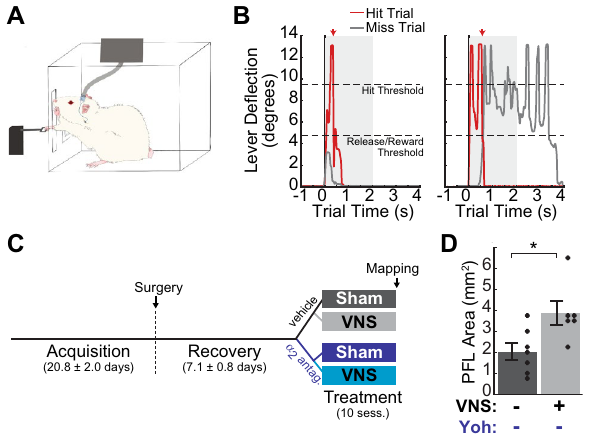
Figure 1. Experimental design. ( A ) Cartoon illustrating the skilled reaching lever-press task and VNS procedures. Rats were required to press and release a lever situated 2 cm outside the training booth within a 2 s window to receive reward ( B ) Example rewarded (Hit, red) trial and unrewarded (Miss, gray) trials from a single pretreatment session. Rats were required to press the lever past the “hit threshold” (9.5 degrees below horizontal) and return it to less than 4.75 degrees from horizontal (“Release/Reward Threshold”) in under 2 s to receive food reward. Unrewarded “Miss Trials” were those in which rats either failed to reach the hit threshold (gray trace, left) or failed to release the lever within the required time window (gray trace, right). ( C ) Experimental design and timeline. Female Sprague–Dawley rats were trained on the lever press task (Acquisition) prior to implantation of VNS cuffs and intracortical cannula. After surgery, rats were trained until stable performance was reestablished (Recovery), and then dynamically allocated to a treatment group. During Treatment, rats received 10 training sessions in which yohimbine (yoh) or control vehicle was infused into M1 30 min prior to behavioral training, and in which VNS or sham stimulation was paired with correct lever-press performance; sham|veh (n = 7), VNS|veh (n = 6), sham|yoh (n = 6), VNS|yoh (n = 6). ( D ) VNS paired with the lever pressing task significantly enlarged the task-relevant proximal forelimb (PFL) area in M1. *p < 0.05, Student’s unpaired